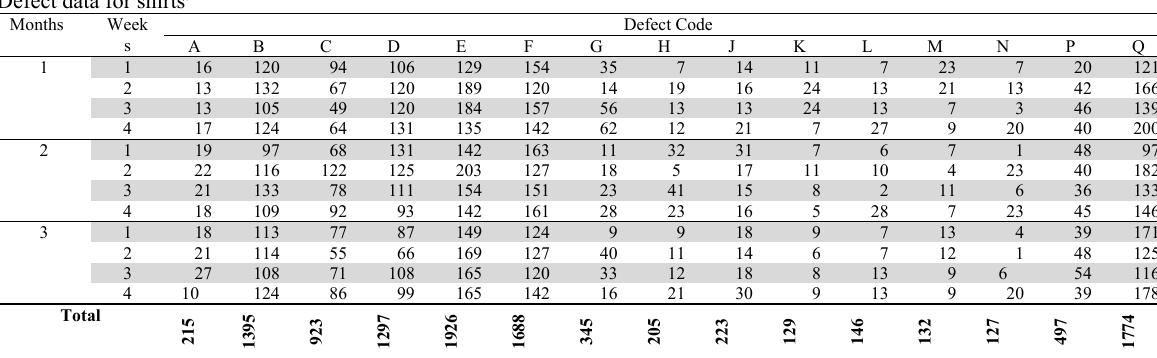
1774 Total number of rejected Average number of rejected shirts per month shirts per shirts per week